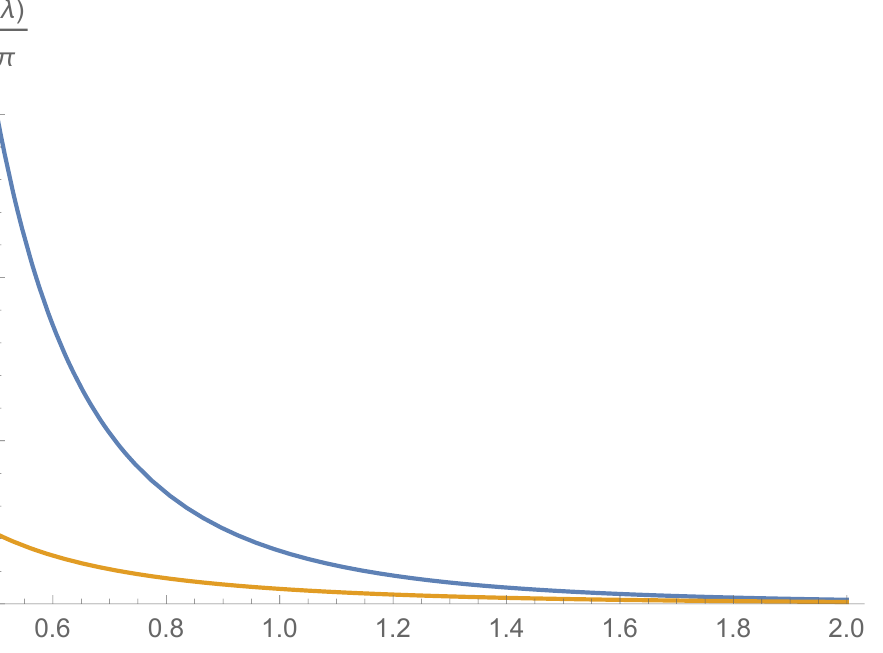
Figure 10. Partition function for a free subluminal Lorentzian particle, the blue line is the correct value while the orange represents the low velocity approximation.